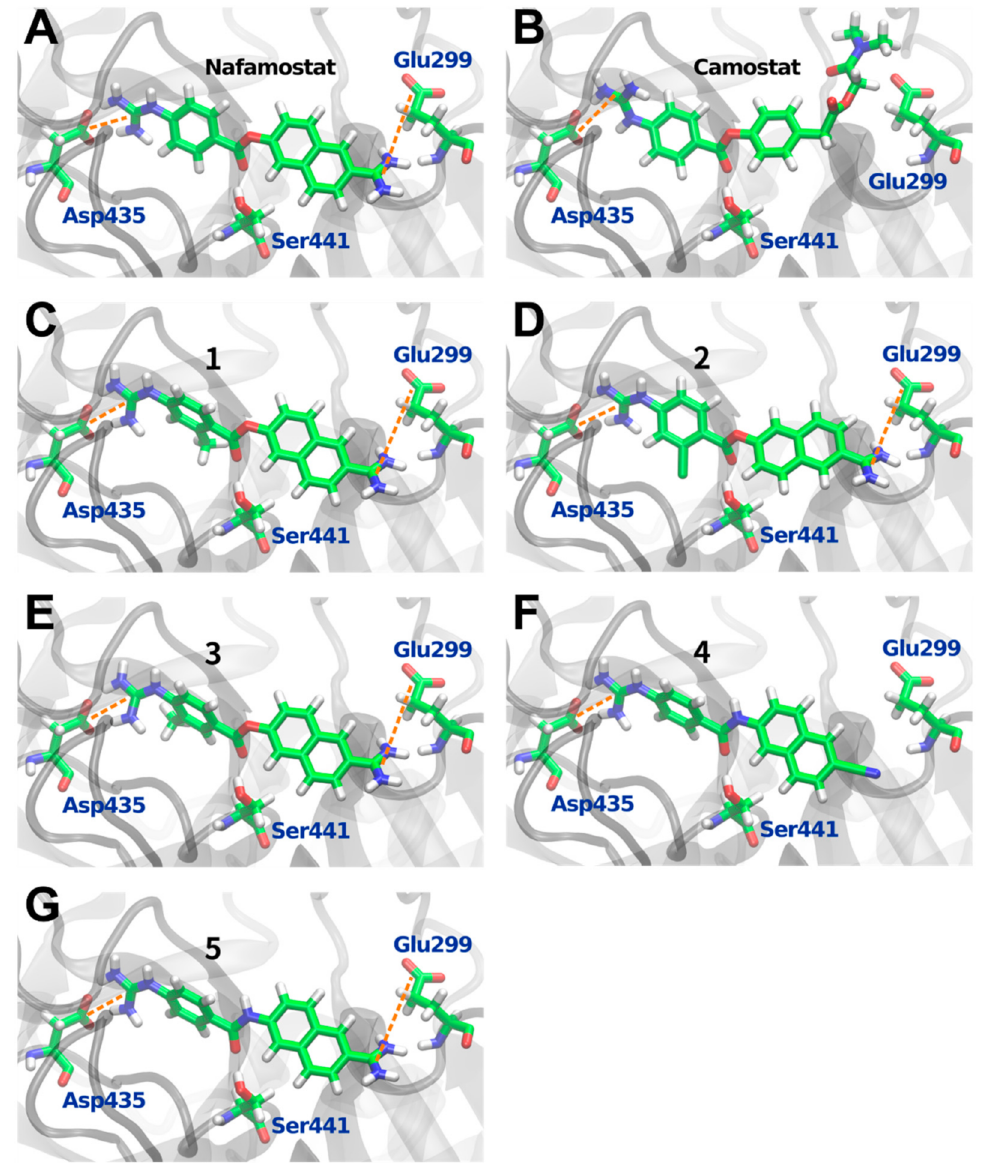
Figure 2. Binding structures of ( A ) nafamostat, ( B ) camostat, and ( C – G ) nafamostat derivatives (compounds 1 to 5 ) at the binding site of TMPRSS2. The gray ribbon represents the backbone structure of TMPRSS2. In ( A ), the cationic guanidino group of nafamostat is in close proximity to the anionic carboxyl group of Asp435, resulting in a strong electrostatic attraction. In addition, the cationic amidino group of nafamostat is close to the anionic carboxyl group of Glu299, resulting in a strong electrostatic attraction. In ( B ), strong electrostatic attraction with Asp435 occurs in camostat as well as in nafamostat, but the interaction with Glu299 is weaker because the cationic amidino group is not present in camostat. The orange dotted lines represent strong electrostatic